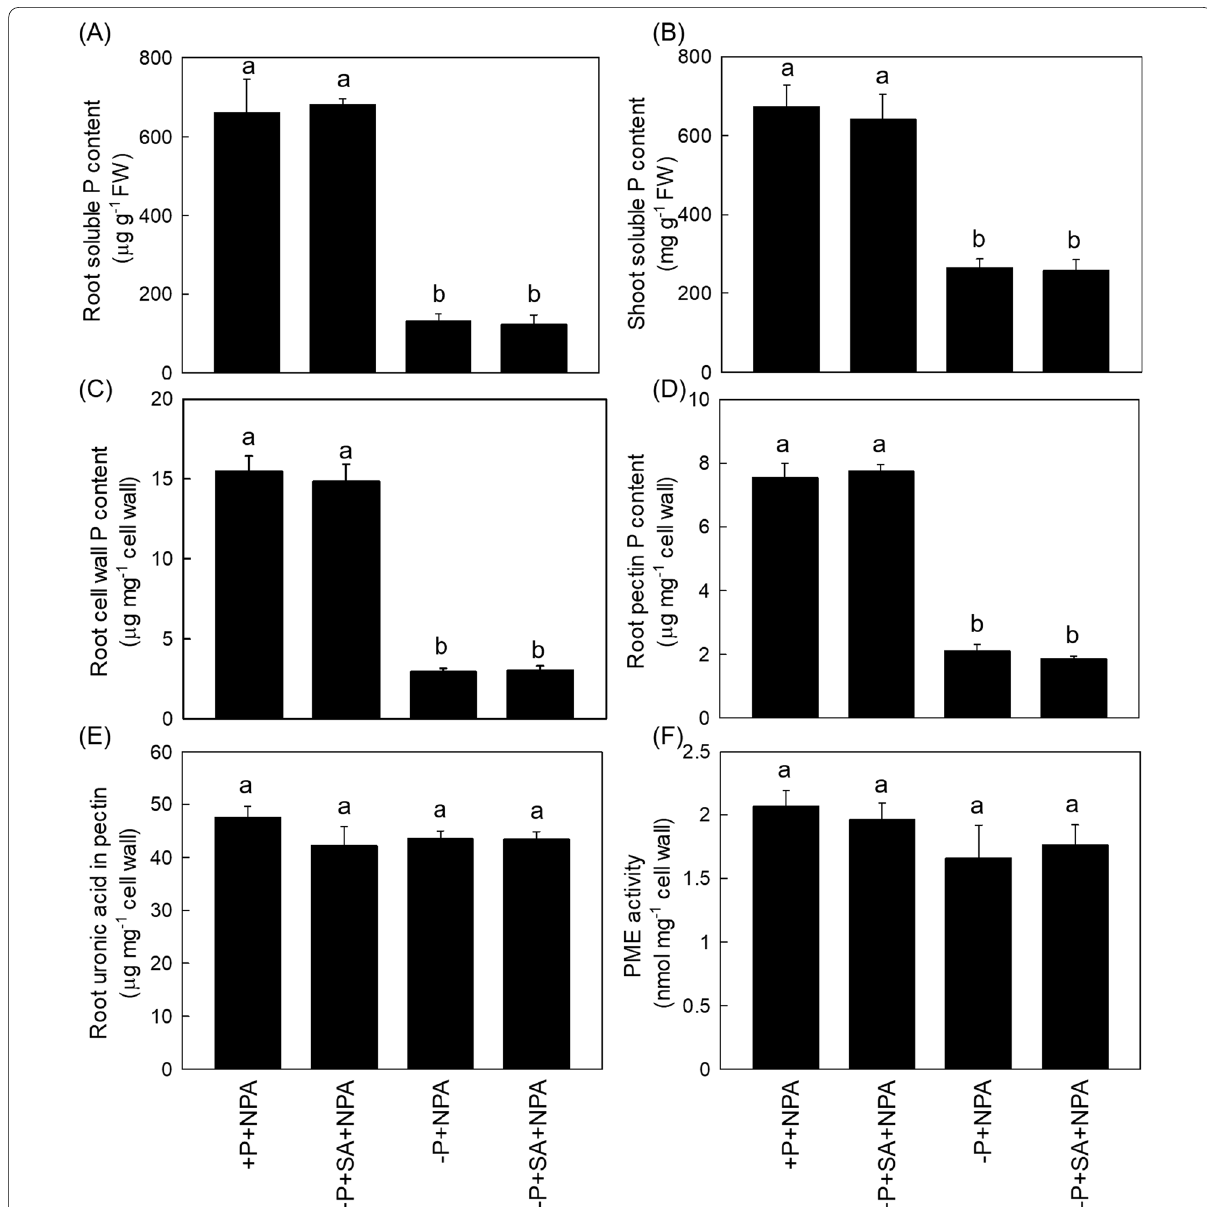
Fig. 9 SA mediated root cell wall P reutilization in rice is dependent on auxin. Soluble P content in root ( A ) and shoot ( B ), root cell wall P content ( C ), cell wall pectin P content ( D ), root pectin content ( E ) and PME activity ( F ) were measured. Data are means represent significant differences by Duncan’s multiple range test at the P <